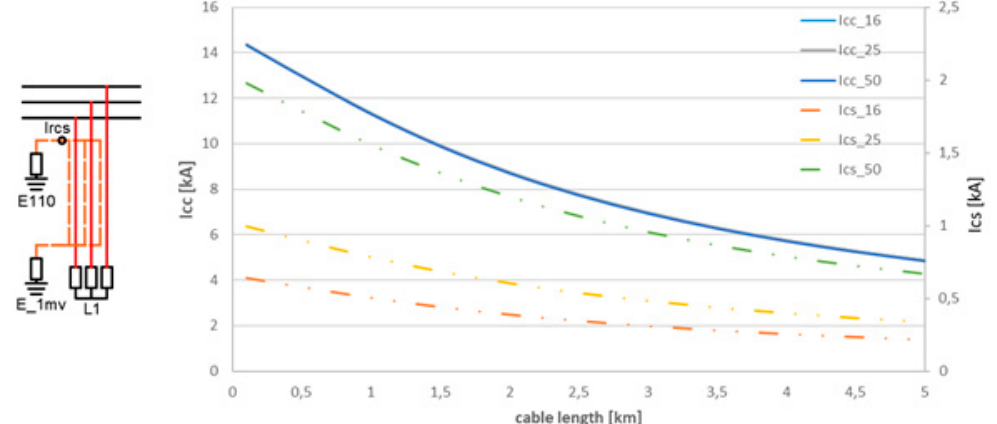
Figure 14. Current induced in cable screens under 3f fault conditions at the end of cable line ( I cc —cable core current; I cs —cable screen current). Configurations are marked with color red—energized cable—and orange—cable screen.